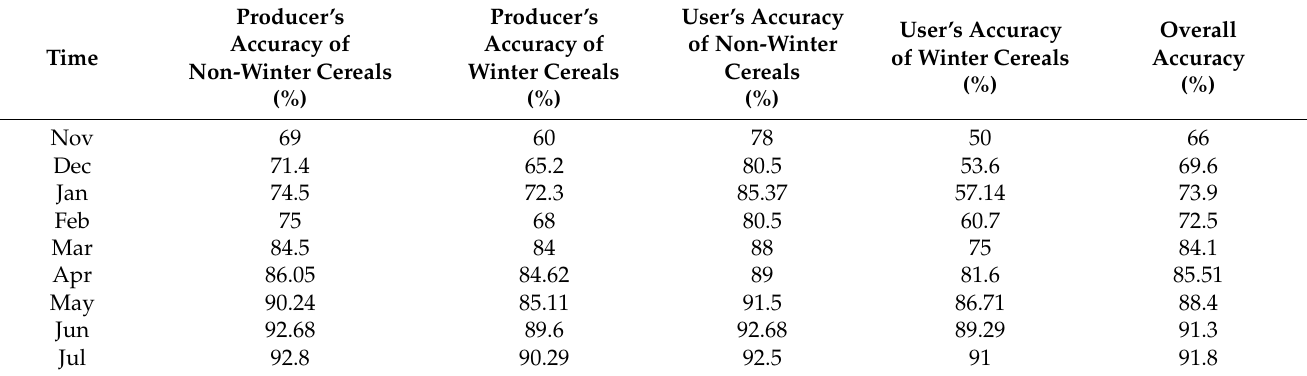
Table 1. The classification accuracy of winter cereals using the TWDTW method with monthly increments for all of